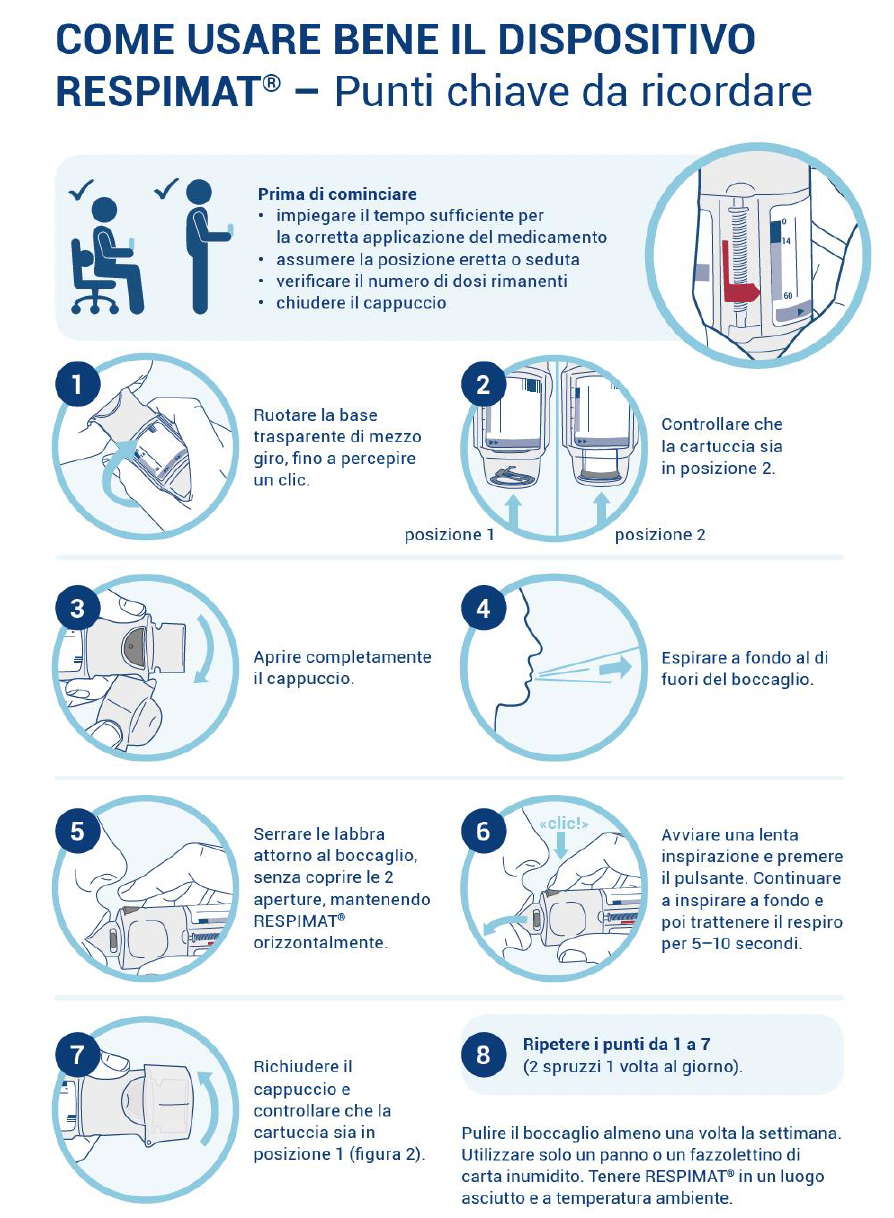
Figure 2. Device handling instructions (as in Respimat ® flyer). Handling instructions are shown in pictures and supported by short text passages. The correct order is ensured by sequential numbering of the individual handling